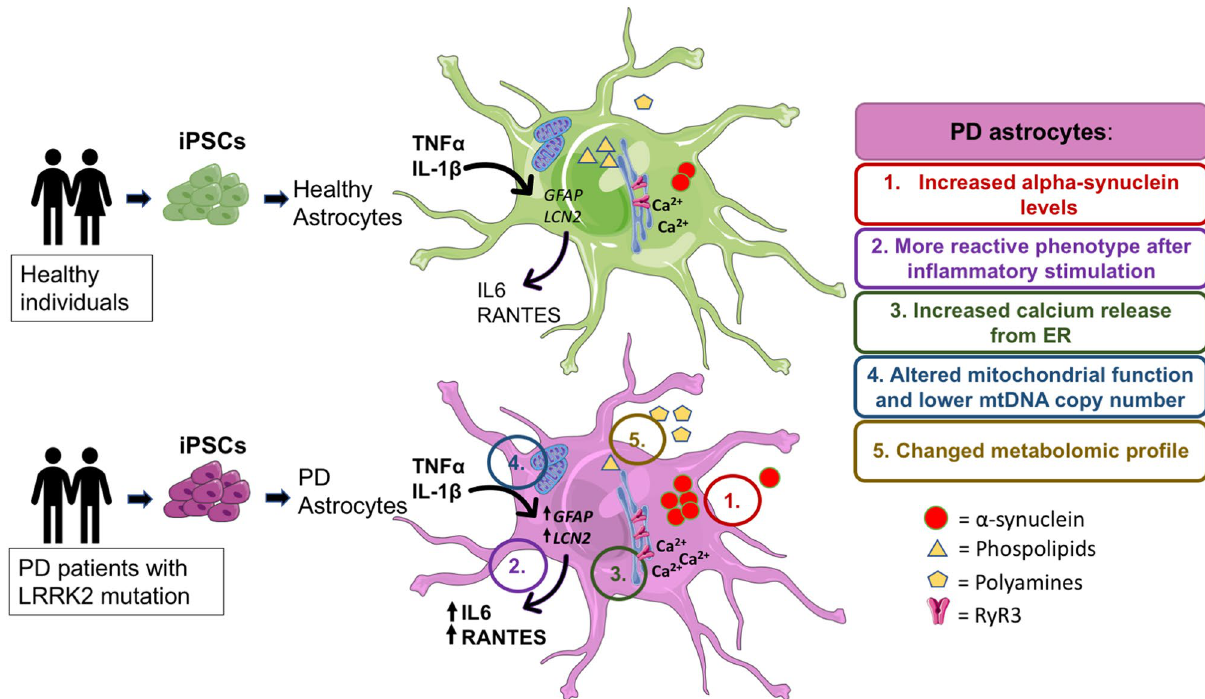
Figure 7. PD patients astrocytes manifest several hallmarks of the disease, these include: (1) increased production of alpha-synuclein, (2) increased reactivity upon inflammatory stimulation, (3) increased astrocytic Ca 2+ levels, (4) mtDNA maintenance defects and (5) metabolomic changes.